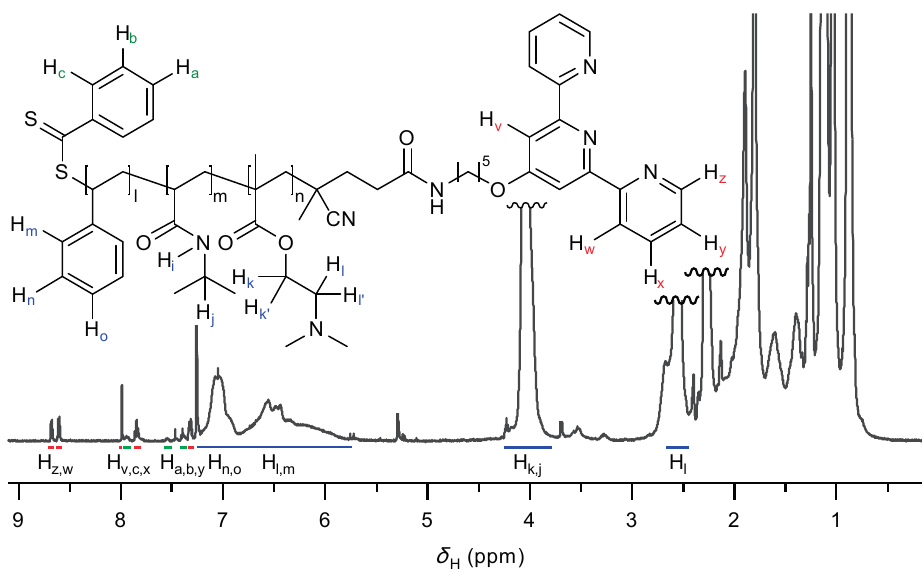
Figure 2. 1 H-NMR spectrum of pure PS- b -PNIPAAm- b -PDMAEMA-tpy triblock terpolymer in deuterated chloroform as the solvent.